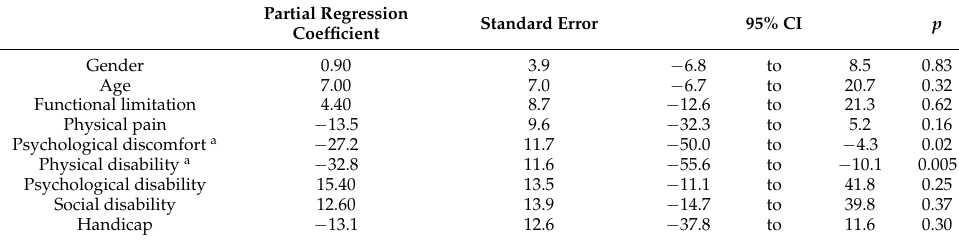
Table 7. Association between oral health-related quality of life subscales and masticatory satisfaction. Partial Regression